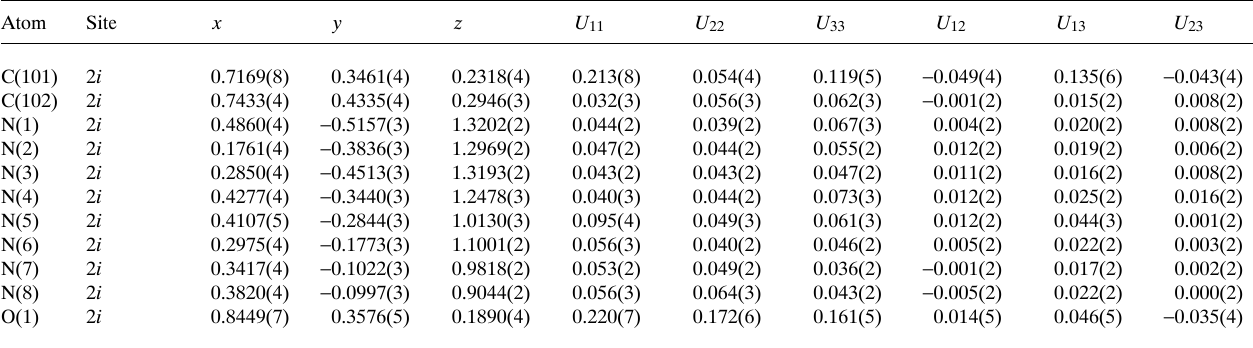
Table 3. C ontinued